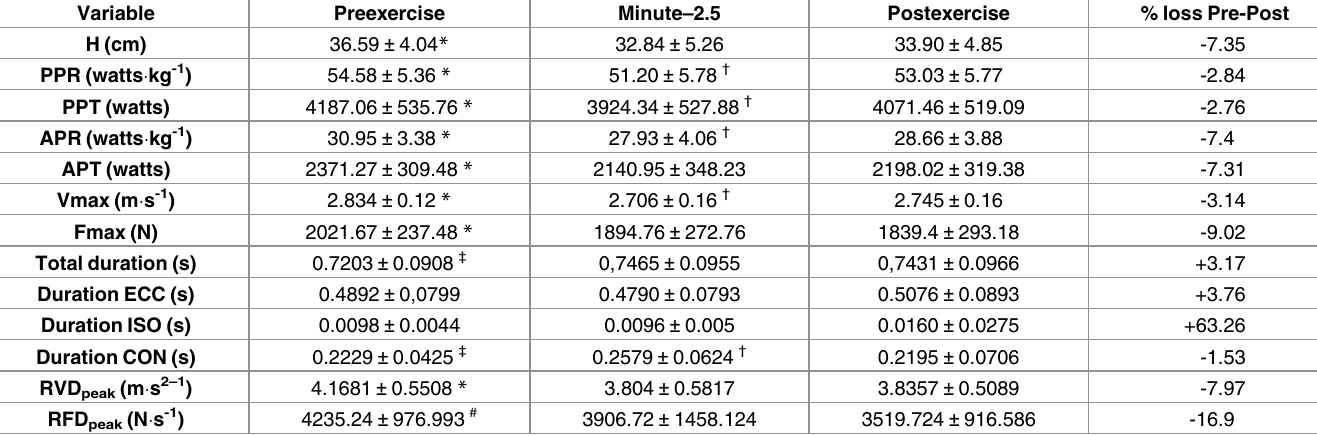
Table 6. Variables reflecting muscular fatigue recorded at the three time points in the weightlifting session in the 34 study